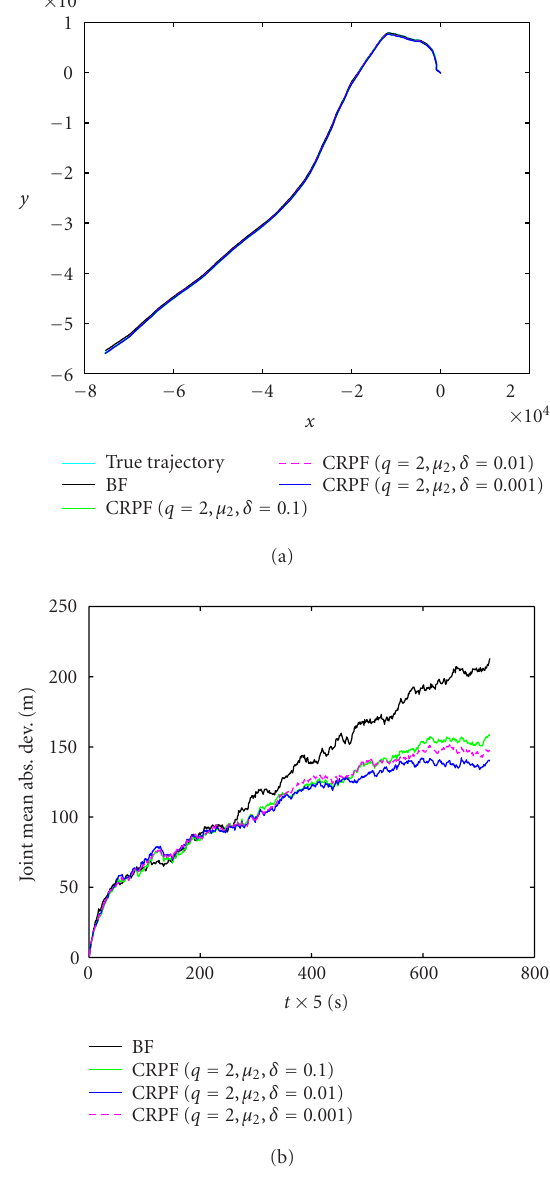
Figure 4: Mixture Gaussian noise processes. T s = 10 seconds. (a) Trajectory. (b) Mean absolute deviation.